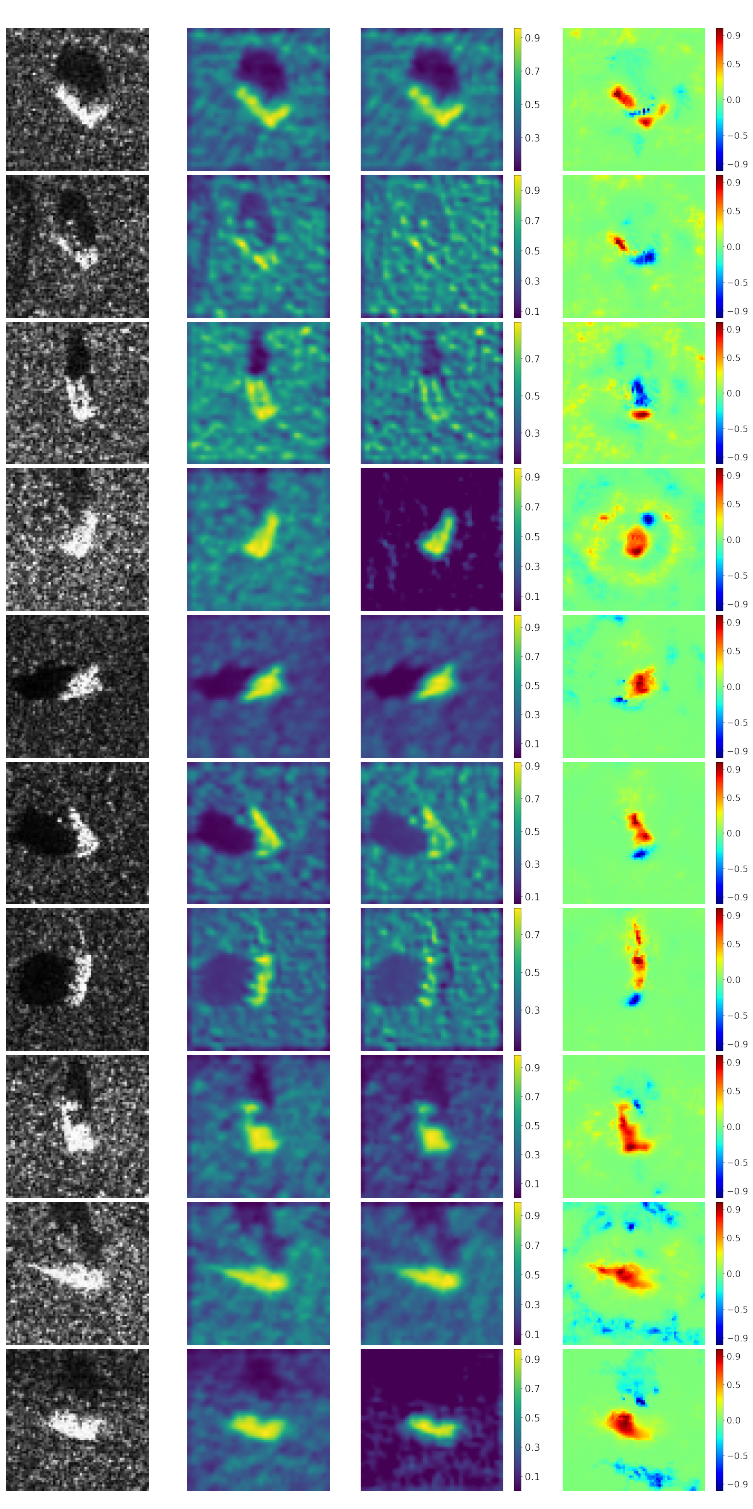
Figure 6. Comparison of Score-CAM, Ablation-CAM and our method. The first column is the SAR images of ten classes: 2S1, BRDM_2, BTR_60, D7, SN_132, SN_9563, SN_C71, T62, ZIL131, and ZSU_23_4. The second, third, and fourth columns are corresponding heatmaps generated by Score-CAM, Ablation-CAM and our method,